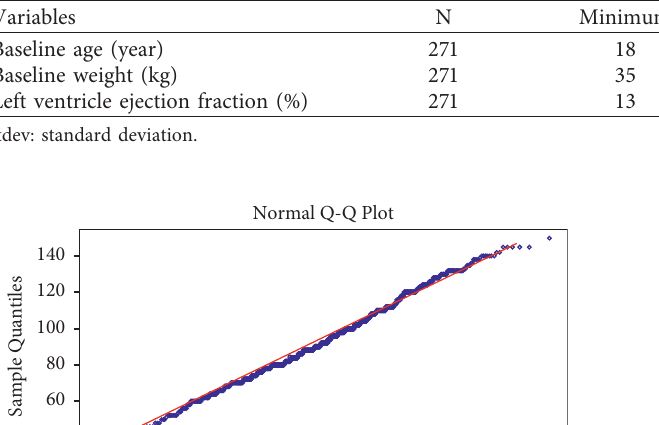
Table 2: Baseline characteristics of continuous variables of HF patients.